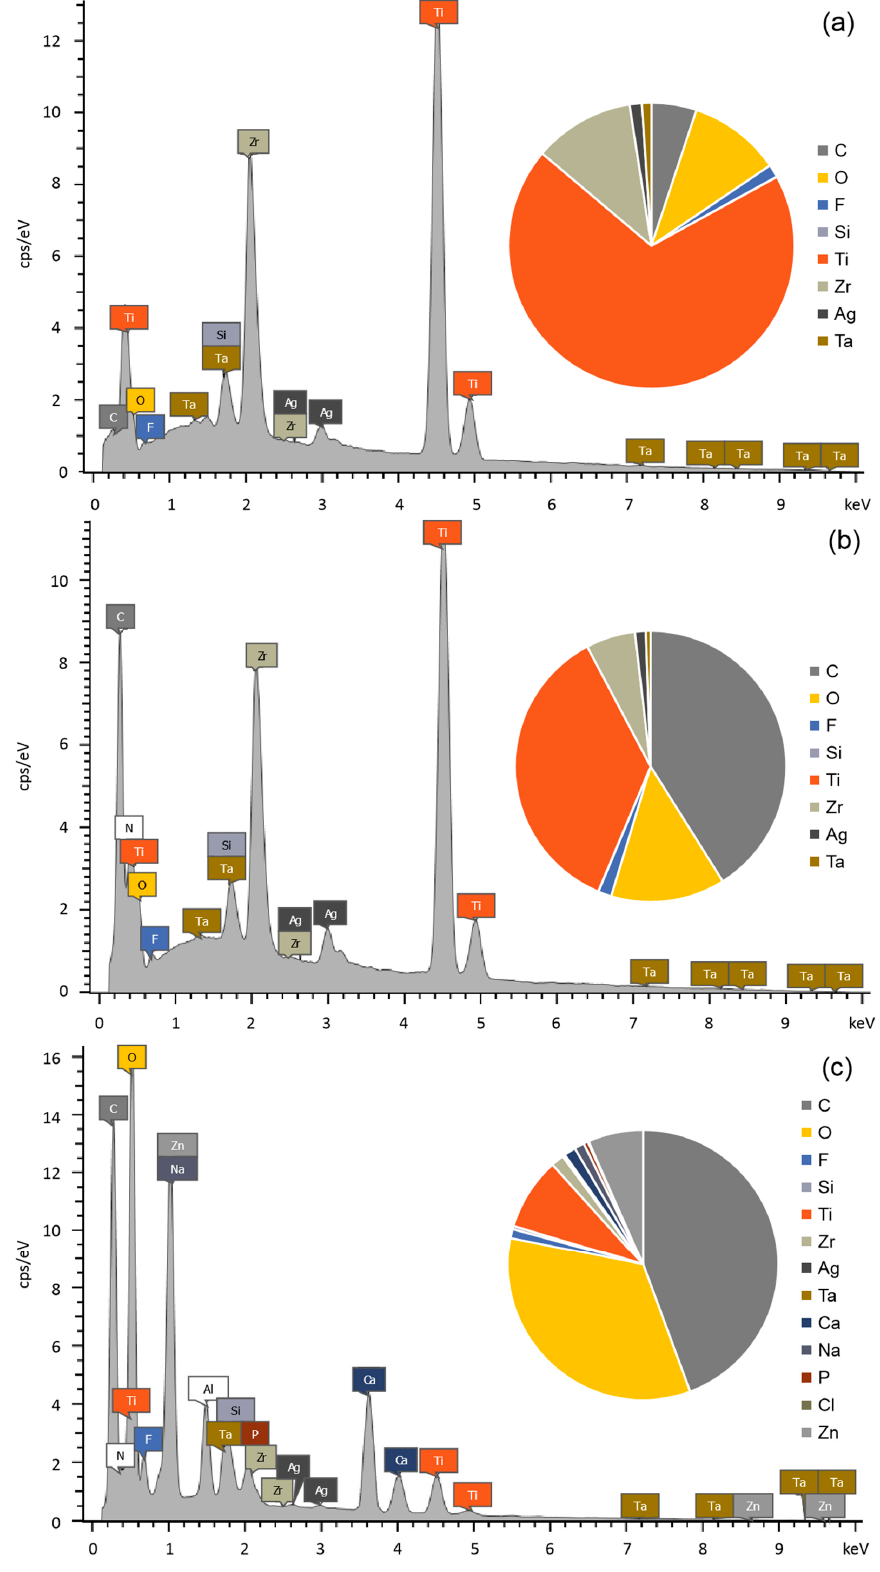
Figure 5. EDX spectra and elemental composition for ( a ) P0; ( b ) P1; ( c )